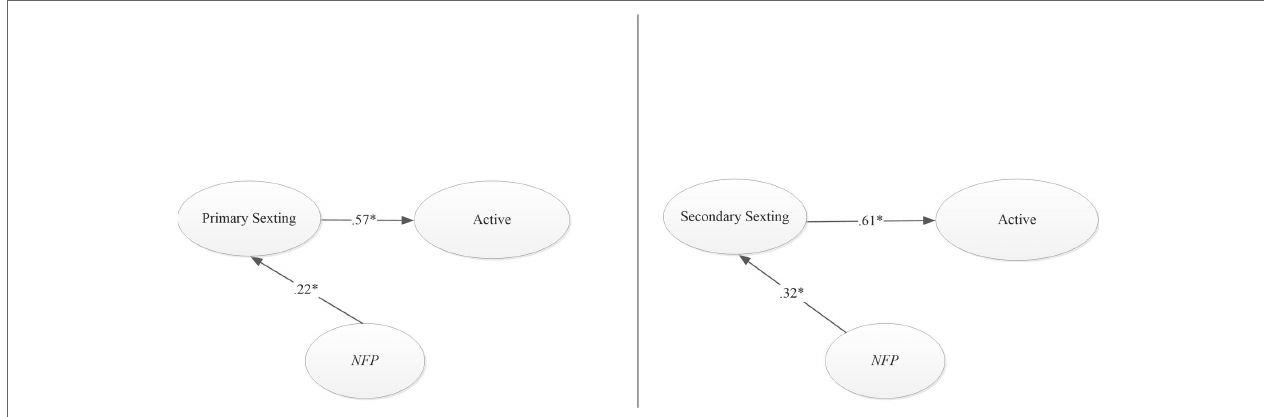
FIGURE 3 | Graphic solution of the models of sexting to active impact including NfP.